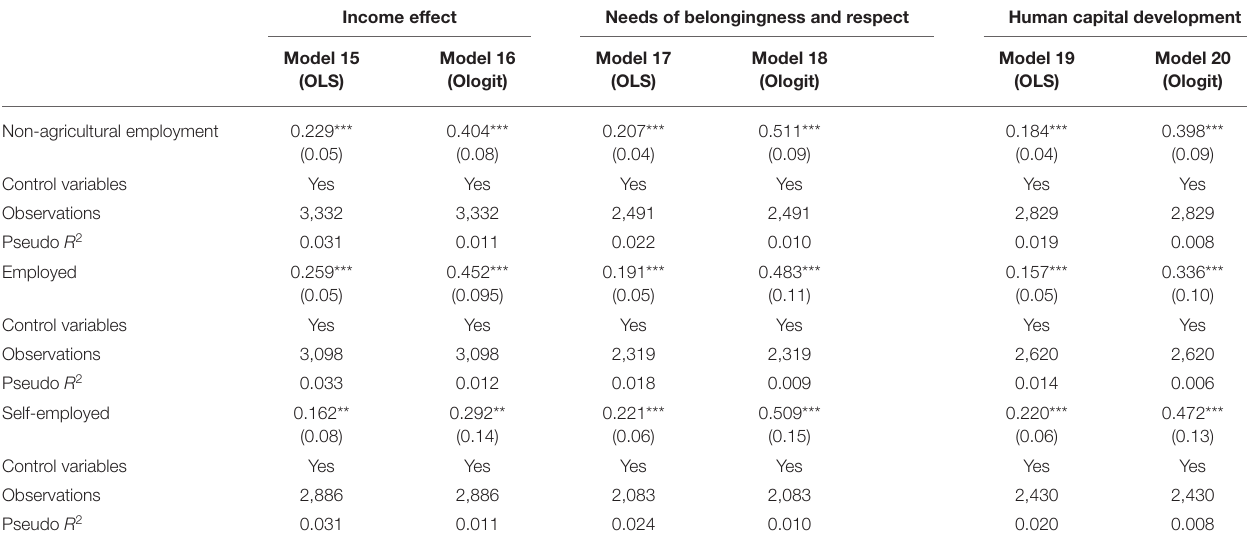
TABLE 7 | Estimation results of independent variables to intermediary